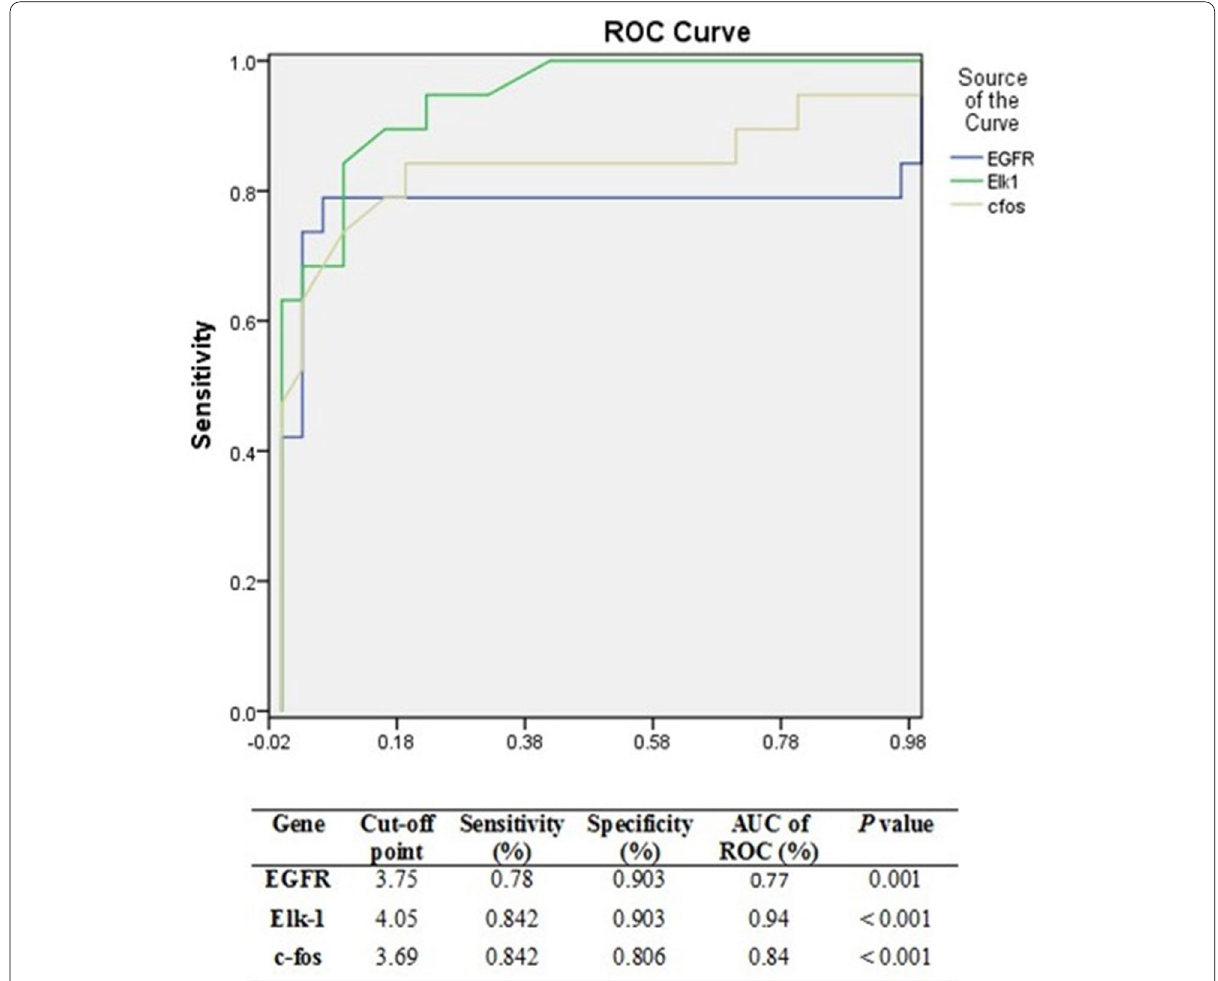
Fig. 1 Receiver operating characteristic (ROC) curves were performed to determine the area under the ROC curve (AUC), sensitivity, specificity, and p ‑value to determine the levels of the EGFR, Elk‑1, and c‑fos that best differentiate the UTUC versus the UBC. The optimal cutoff values were calculated as the marker level that maximizes the sensitivity and